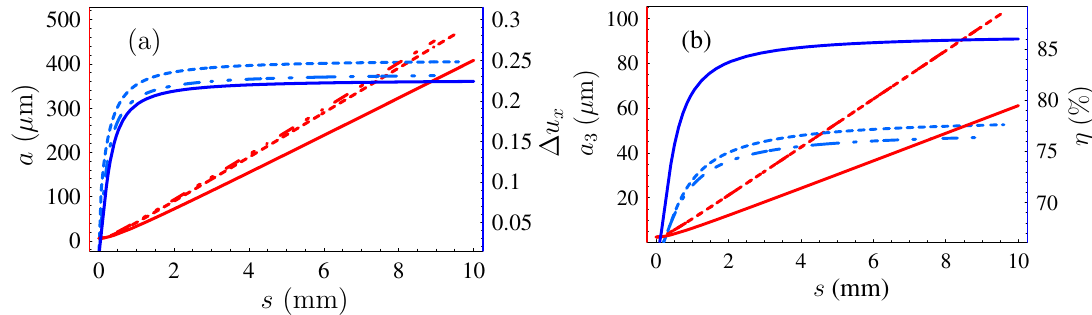
FIG. 7. (Color) Simulation of the space-charge blowup of a large energy spread compact electron bunch with input parameters: charge (cid:1) 6 MeV , transverse radius a (cid:1) 6 (cid:4) m , half-length a (cid:1) 2 : 5 (cid:4) m , energy spread (cid:5) (cid:1) 65% , divergence Q (cid:1) 100 pC , beam energy E 0 3 (cid:1) 2 mrad , typical distance between macroparticles n (cid:6) 1 = 3 ’ 266 nm , and cutoff radius r (cid:1) 100 nm . Evolution of (a) transverse x 0 0 max 0 , (b) longitudinal half-length a and energy spread (cid:5) as a function of propagation radius a and transverse RMS momentum spread (cid:1) u x 3 distance s is shown using the envelope model (solid), 3D-PPI (dashed), and shell method (cid:1) 17 (cid:5) 10 3 (cid:7) (cid:8) where I . The ratio (cid:6) approximately A b 0 0 characterizes the initial averaged magnitude of the space- approximation, i.e., when transverse current is negligible.